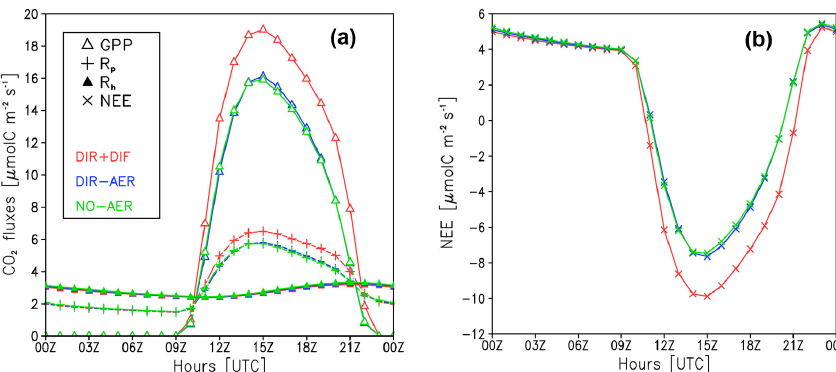
Figure 17. (a) Mean diurnal cycle of CO 2 fluxes (µmolCm − 2 s − 1 ) during September 2010 in the LBAR, with different symbols indicating the processes of GPP (hollow triangles), R P (plus symbols), and R H (filled triangles). (b) Mean diurnal cycle of CO 2 fluxes (µmolCm − 2 s − 1 ) associated with NEE during the same period and in the same area. In both plots, different colors indicate the modeling experiments: green is for NO-AER, blue is for DIR-AER, and red is for DIR+DIF.